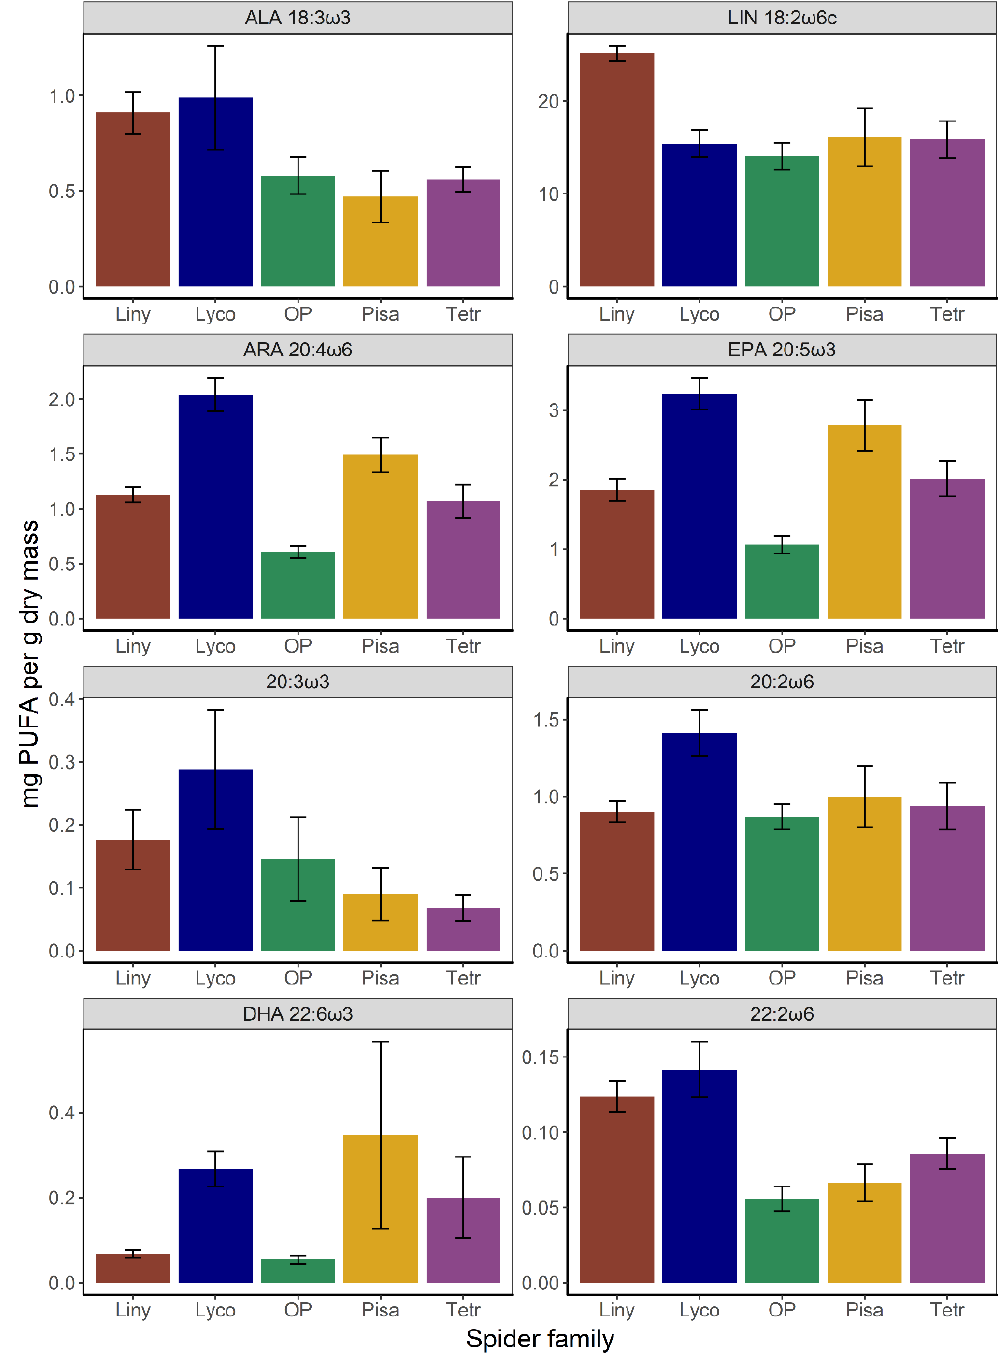
Figure 7. Mean ± SE PUFA content per spider family of eight specific PUFAs. Spider family abbreviations: Liny, Linyphiidae; Lyco, Lycosidae; OP, Opiliones; Pisa, Pisauridae; Tetr, Tetragnathidae. Please note the di ff erent scales on the y -axes.